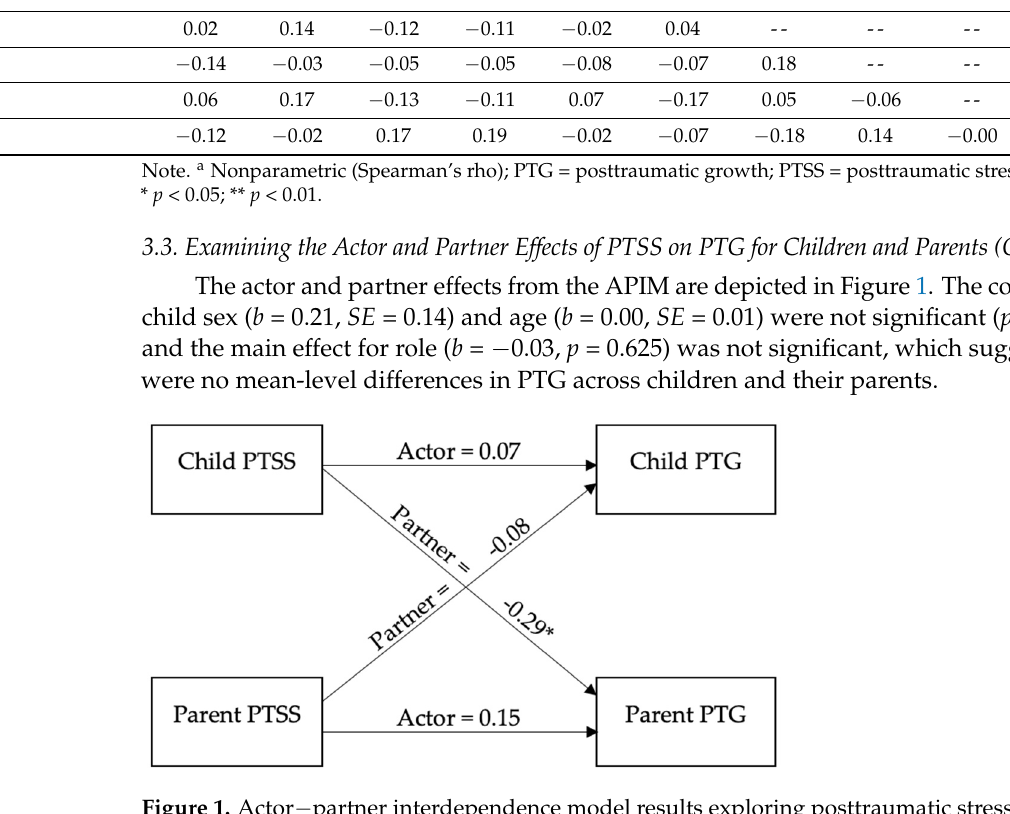
Figure 1. Actor − partner interdependence model results exploring posttraumatic stress symptoms predicting posttraumatic growth among child–parent dyads. Note. * p < 0.05.